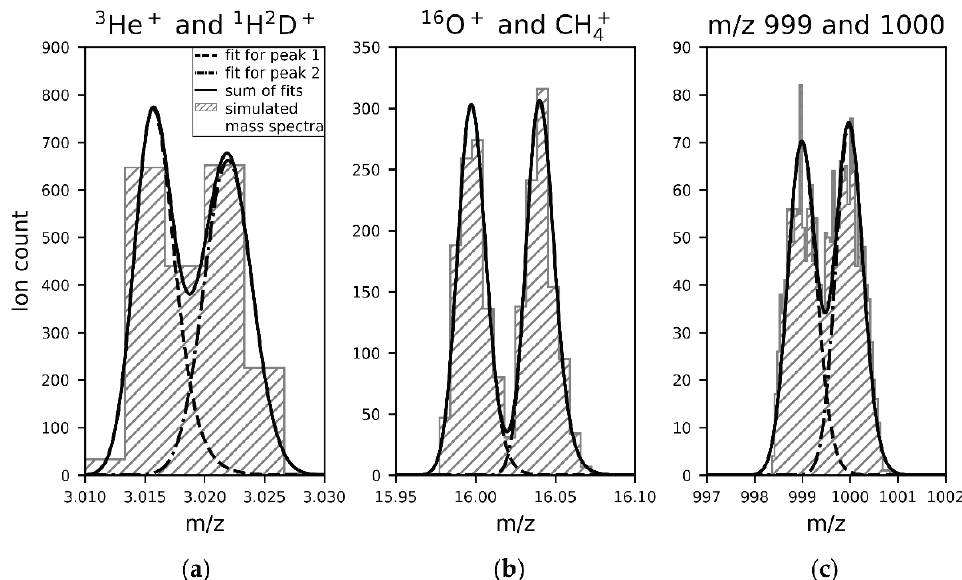
Figure 3. The mass resolution of this instrument is comparable to NIM’s mass resolution for higher masses, and even better for lower masses (see text for references). This performance is sufficient for resolving, e.g., 1 H 2 D/ 3 He and CH 4 /O, and thus answering related scientific questions.